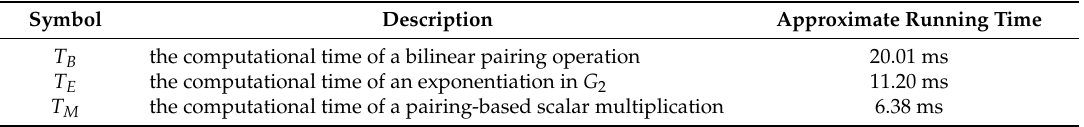
Table 1. Definition of utilized